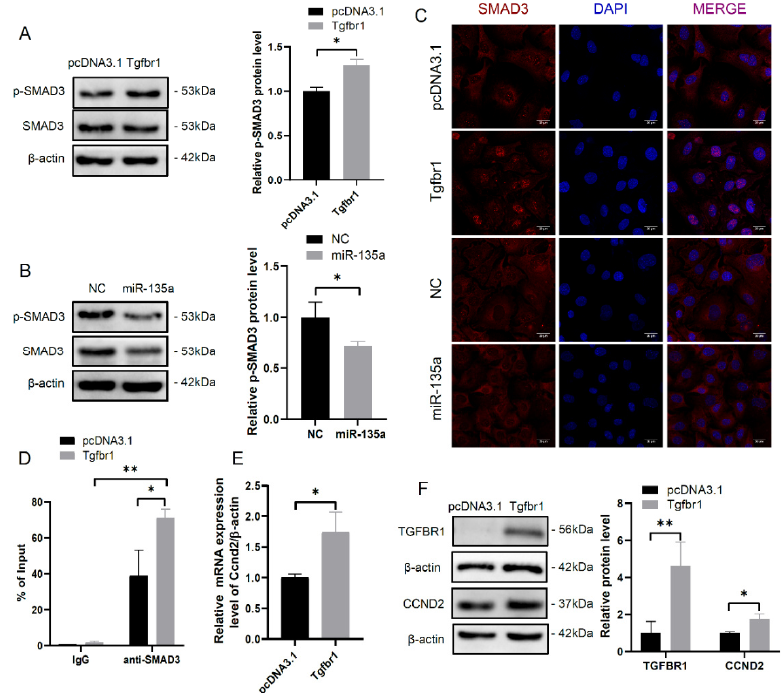
Figure 4. Tgfbr1 enhances SMAD3-mediated Ccnd2 promoter activity. ( A ) Western blot analysis of p-SMAD3 protein level in Tgfbr1 overexpressed mGCs. The relative quantification of p-SMAD3 protein level in Tgfbr1 overexpressed mGCs was shown in the right panel. ( B ) Western blot analysis of p-SMAD3 protein level in mGCs transfected with miR-135a mimics. The relative quantification of p-SMAD3 protein level in mGCs transfected with miR-135a mimics was shown in the right panel. ( C ) The subcellular distribution of SMAD3 was detected by immunofluorescence assay in mGCs treated with Tgfbr1 overexpression or miR-135a mimics. Scale bar: 20 μ m. ( D ) ChIP analyses of SMAD3 binding sites in Ccnd2 promoter region followed by qPCR. ( E ) Relative mRNA level of Ccnd2 in Tgfbr1 overexpressed mGCs. ( F ) Western blot analysis of CCND2 protein level in Tgfbr1 overexpressed mGCs. The means ± SD were calculated from three independent experiments. * p < 0.05, ** p < 0.01.